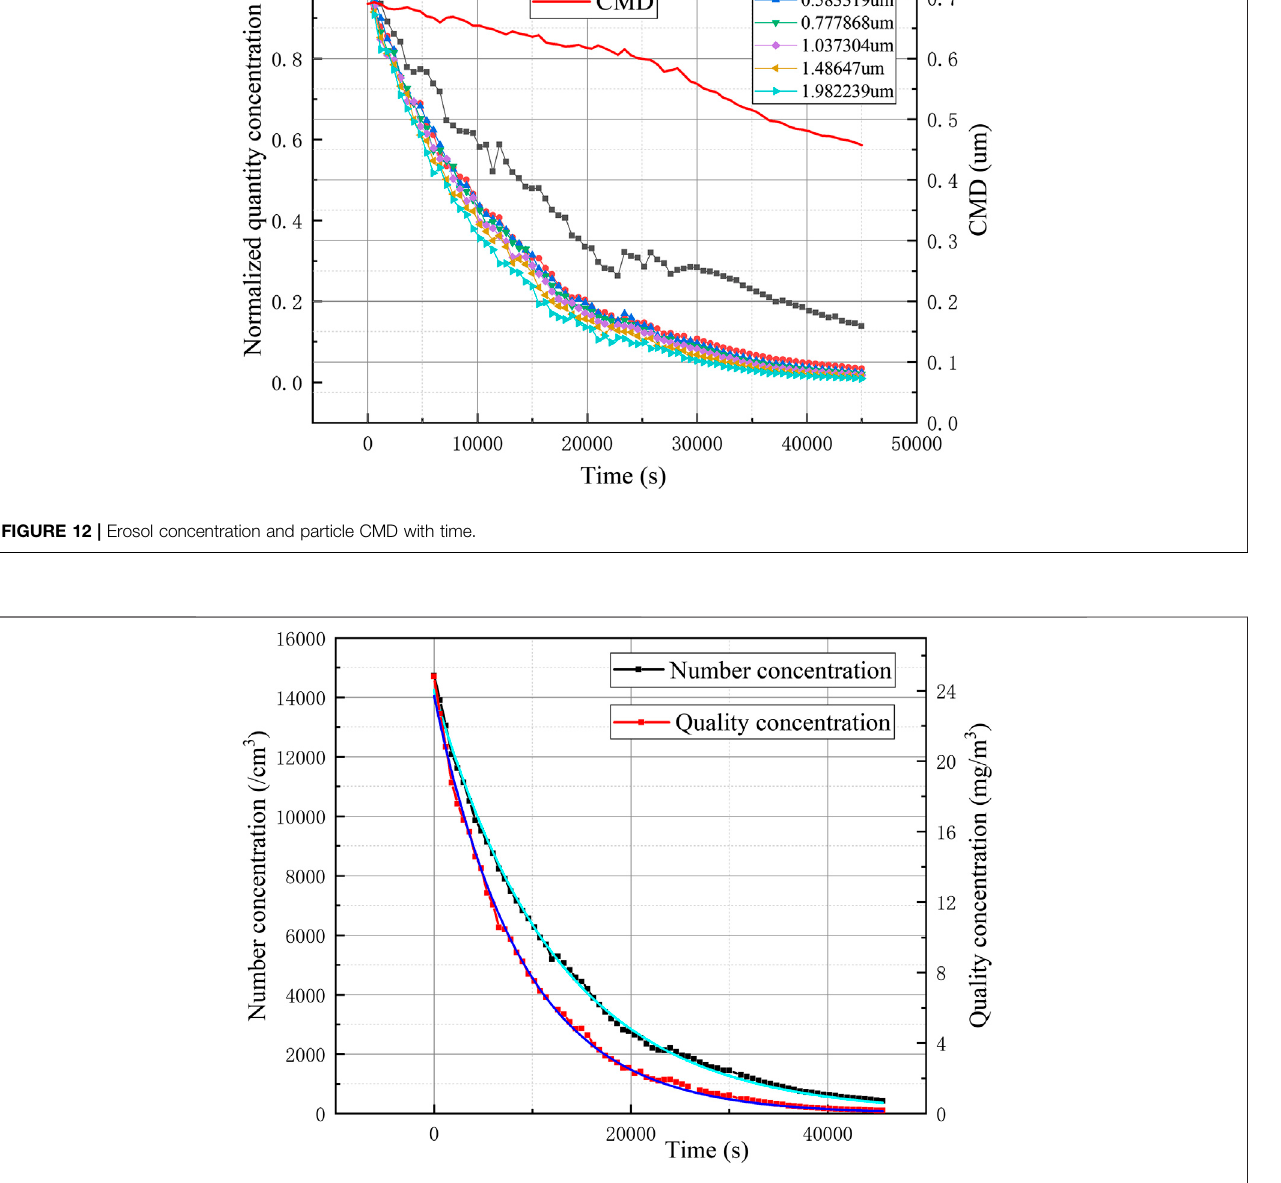
FIGURE 13 | Variations in mass concentrations over